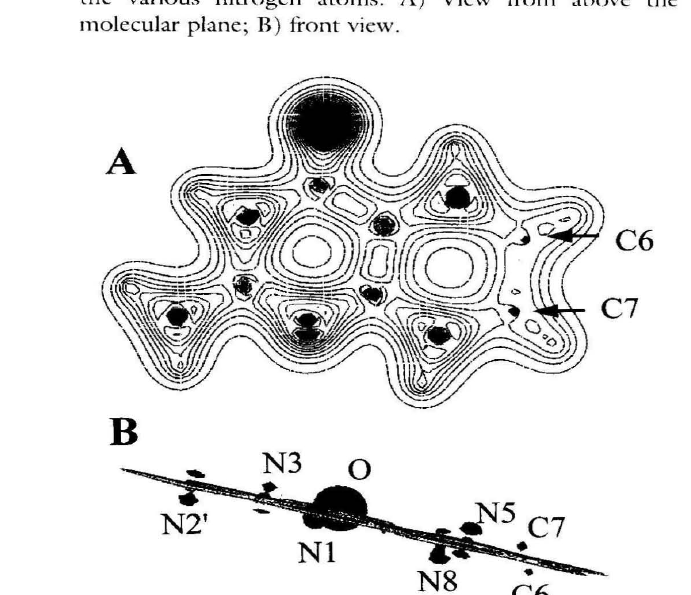
hgure 2. Contour and isodensity plot of electronic charge density of 7,8-dihydropterin. Contour levels are tl'om 0.05 a.u. (outermost isoline) to 0.50 a.u. in steps of 0.05 a.u. Also shown is the isodensity surface at a \'alue of 0.54 a.u. showing specifically the differences at the various nitrogen atoms. A) View from above the molecular plane; B) front view.